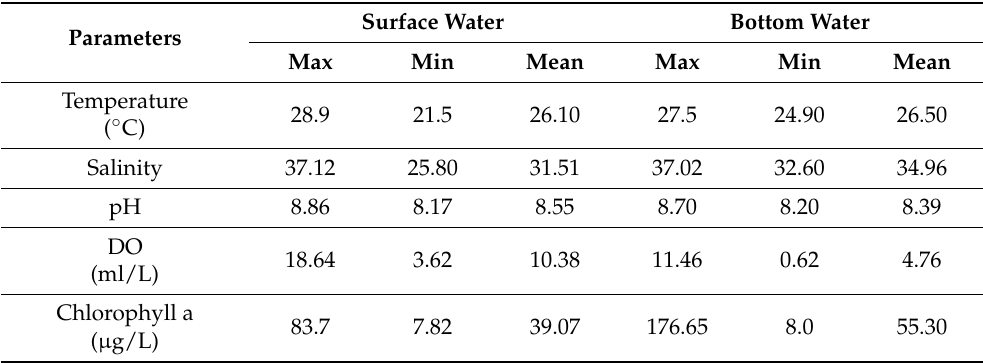
Table 1. Physical and chemical properties of Al-Arbaeen lagoon water.